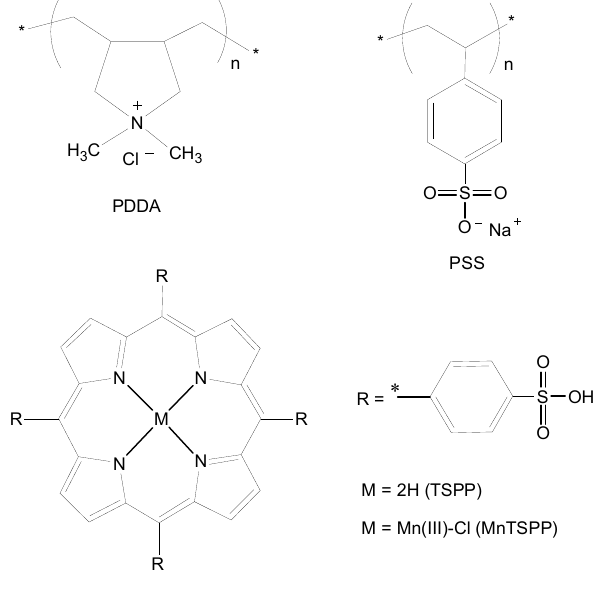
Figure 1. Structural models of the polycation (PDDA), polyanion (PSS), and porphyrins (TPPS and MnTPPS) used for the thin film